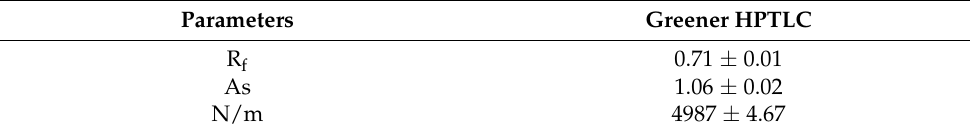
cluded in Table 1. The suggested densitometry technique's R f , As, and N/m for FFA meas- urement were found to be 0.71, 1.06, and 4987, respectively, which were reliable for FFA analysis. Table 1. System appropriate parameters of FFA for the ecofriendly HPTLC assay (mean ± SD; n = 3).